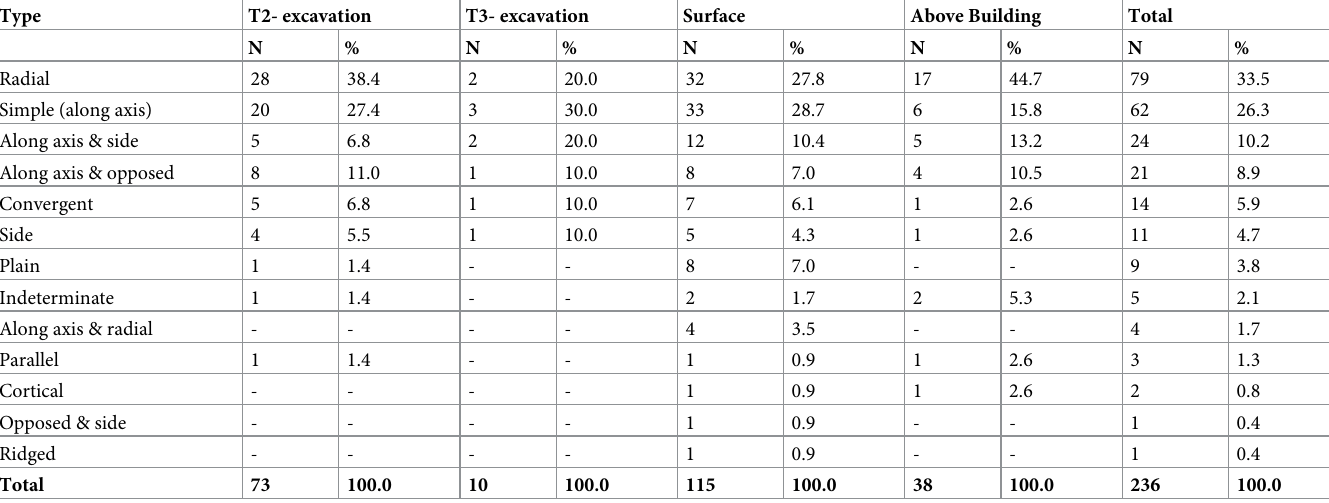
Table 14. Dorsal face scar pattern of flint thinning flakes by